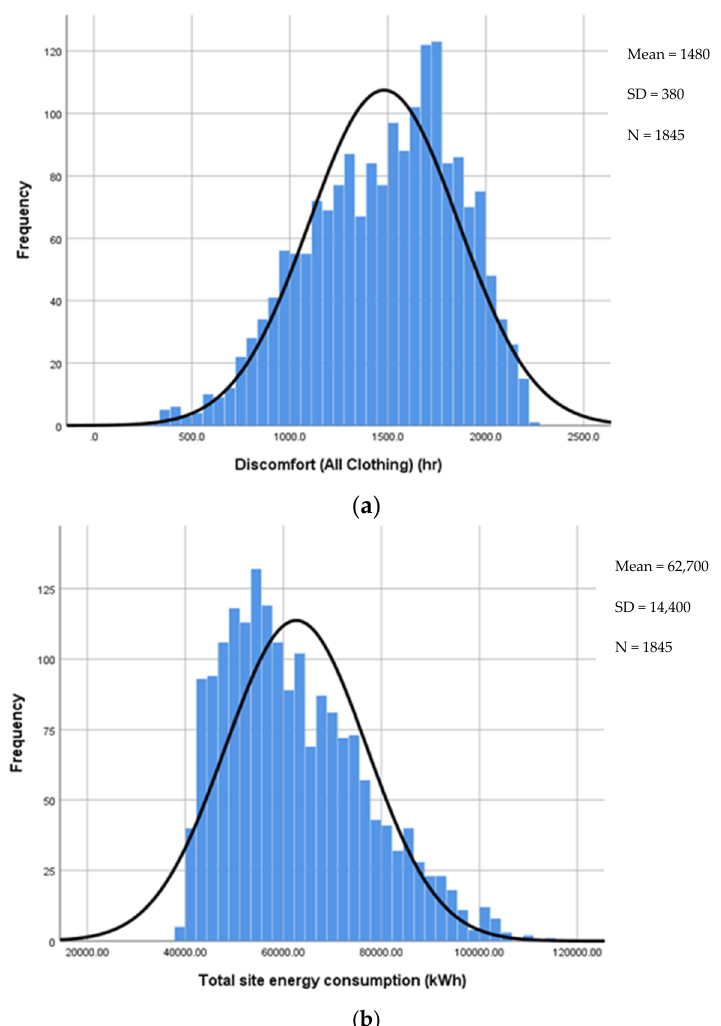
Figure 16. Normal distribution of ( a ) students’ discomfort hours and ( b ) building energy consumption.